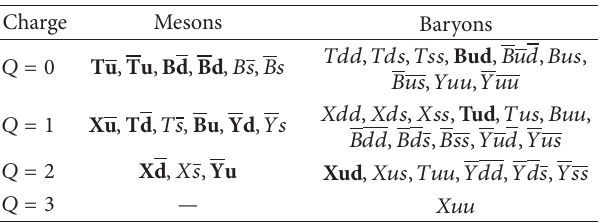
Table 5: 𝑄𝑞 ( 𝑄𝑞 ) mesons and 𝑄𝑞𝑞 ( 𝑄𝑞 𝑞 ) (anti-)baryons involving 𝑄 = 𝑋 bold font are hadrons of which yields are expected to be substantial at the LHC, as predicted in [25] for penetration depths between 0 and 3 meters. For simplicity, only the neutral and positively charged hadrons are